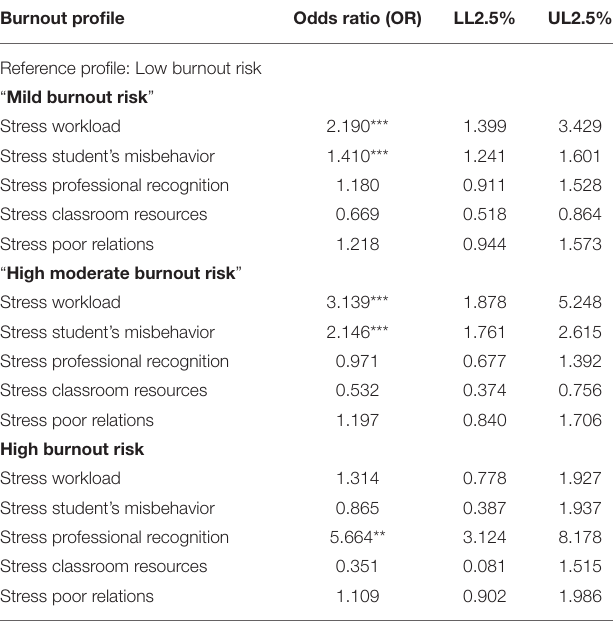
TABLE 5 | Effects of predictors on membership in latent profiles of TB risk. Odds ratios (OR), 95% confidence interval for the effects of work-related stress on TB profile